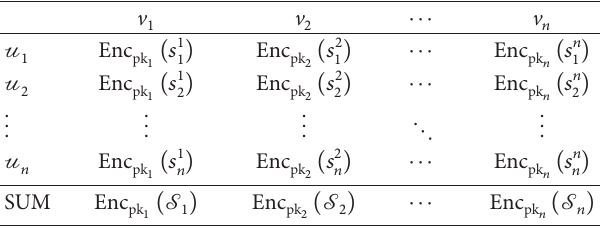
Table 2: Outcome table released by the data